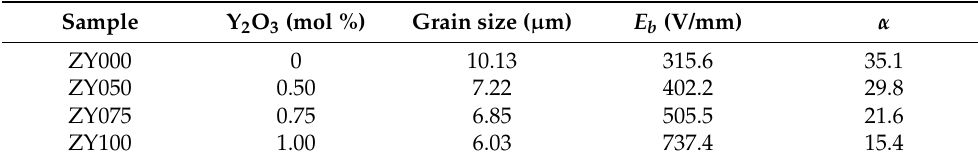
Figure 13. J–E characterization of ZnO varistors modified with Y 2 O 3 . Reprinted from [79], Copyright 2011, with permission from Elsevier. Table 6. Nonlinear parameters of ZnO varistors modified with Y 2 O 3